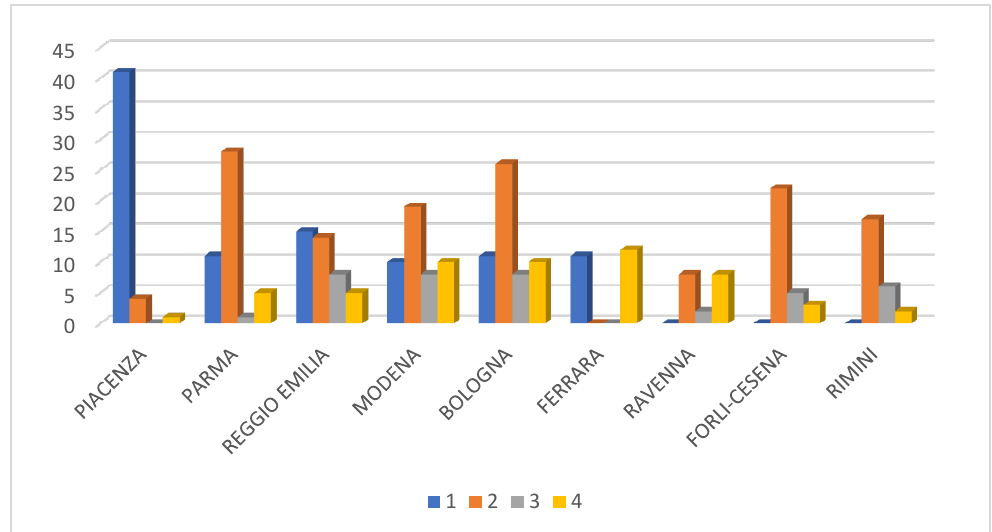
Figure 11. Population of each risk cluster by province in the Emilia Romagna region. In the y -axis, the number of municipalities has been reported.